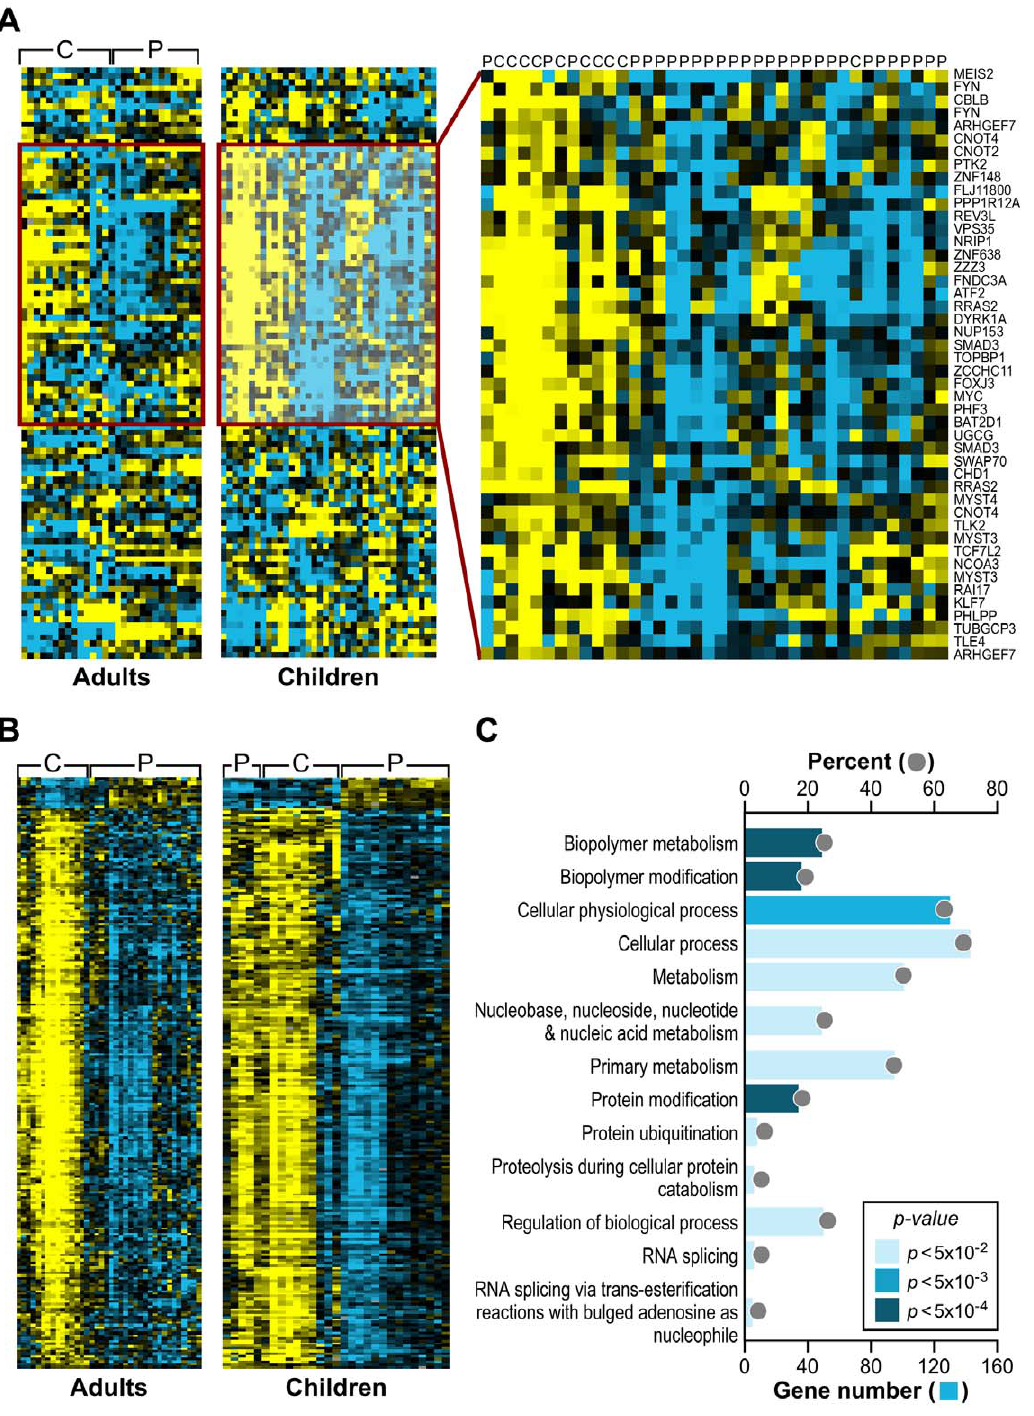
Figure 2. Analogous gene expression responses in blood from children and adults with FRDA. (A) A common gene signature is representative of a genotoxic stress response found by Gene Set Analysis. Twenty-three genotoxic stress response gene sets were searched for common genes. This heat map, generated by unsupervised clustering, displays the genes present in at least 6 of the 23 gene sets and compares transcript levels between FRDA patients, the adult and children cohorts, and controls. Yellow=upregulated; Blue=downregulated. C=Control; P=Patient. Note that while three patients and one control did not segregate with their respective groups, all adult patients and controls clustered in two separate groups in this unsupervised clustering. (B) Heat-map generated by unsupervised clustering of FRDA and control samples, which displays the overlap of significantly differentially expressed genes (SAM FDR , 0.023%; n=228) in the FRDA children and FRDA adults (overlap p # 0.007). C=control; P=patient. (C) A selected list of significant GO groups representing the overlap gene list described in (B). All controls used for comparison to the FRDA children are young adults (see Table S1). The percent of total (displayed with a gray ball) is based on the number of significantly changed genes out of the total number of genes assigned to each gene ontology term. The gene number for each GO group is shown with a blue bar, the intensity of which is indicative of the p -value.